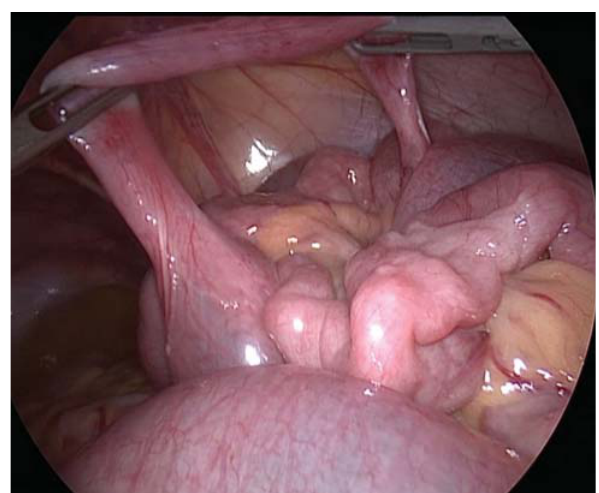
Fig. 1 First view of Meckel ’ s diverticulum. The structure is not in fl ammatory, with the same vascularization of the rest of the